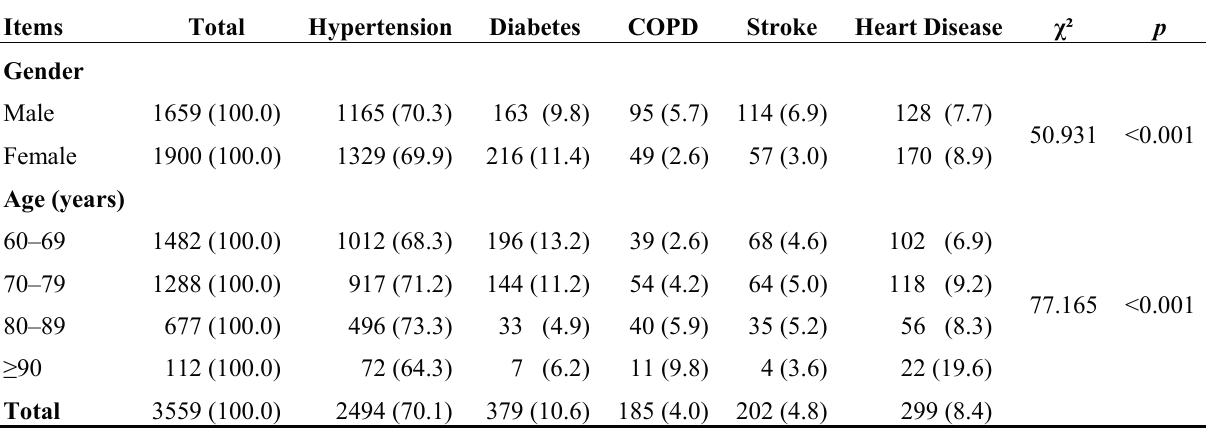
Table 2. The prevalence of major NCDs among rural elderly people by age, gender [ n